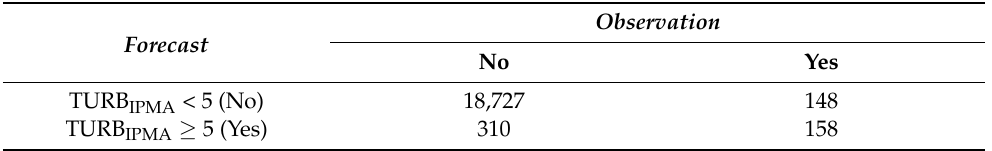
Table 6. A 2 × 2 contingency table for the verification of the index TURB IPMA for a threshold of 5. MOG turbulence is considered an event. In this case, the base rate is